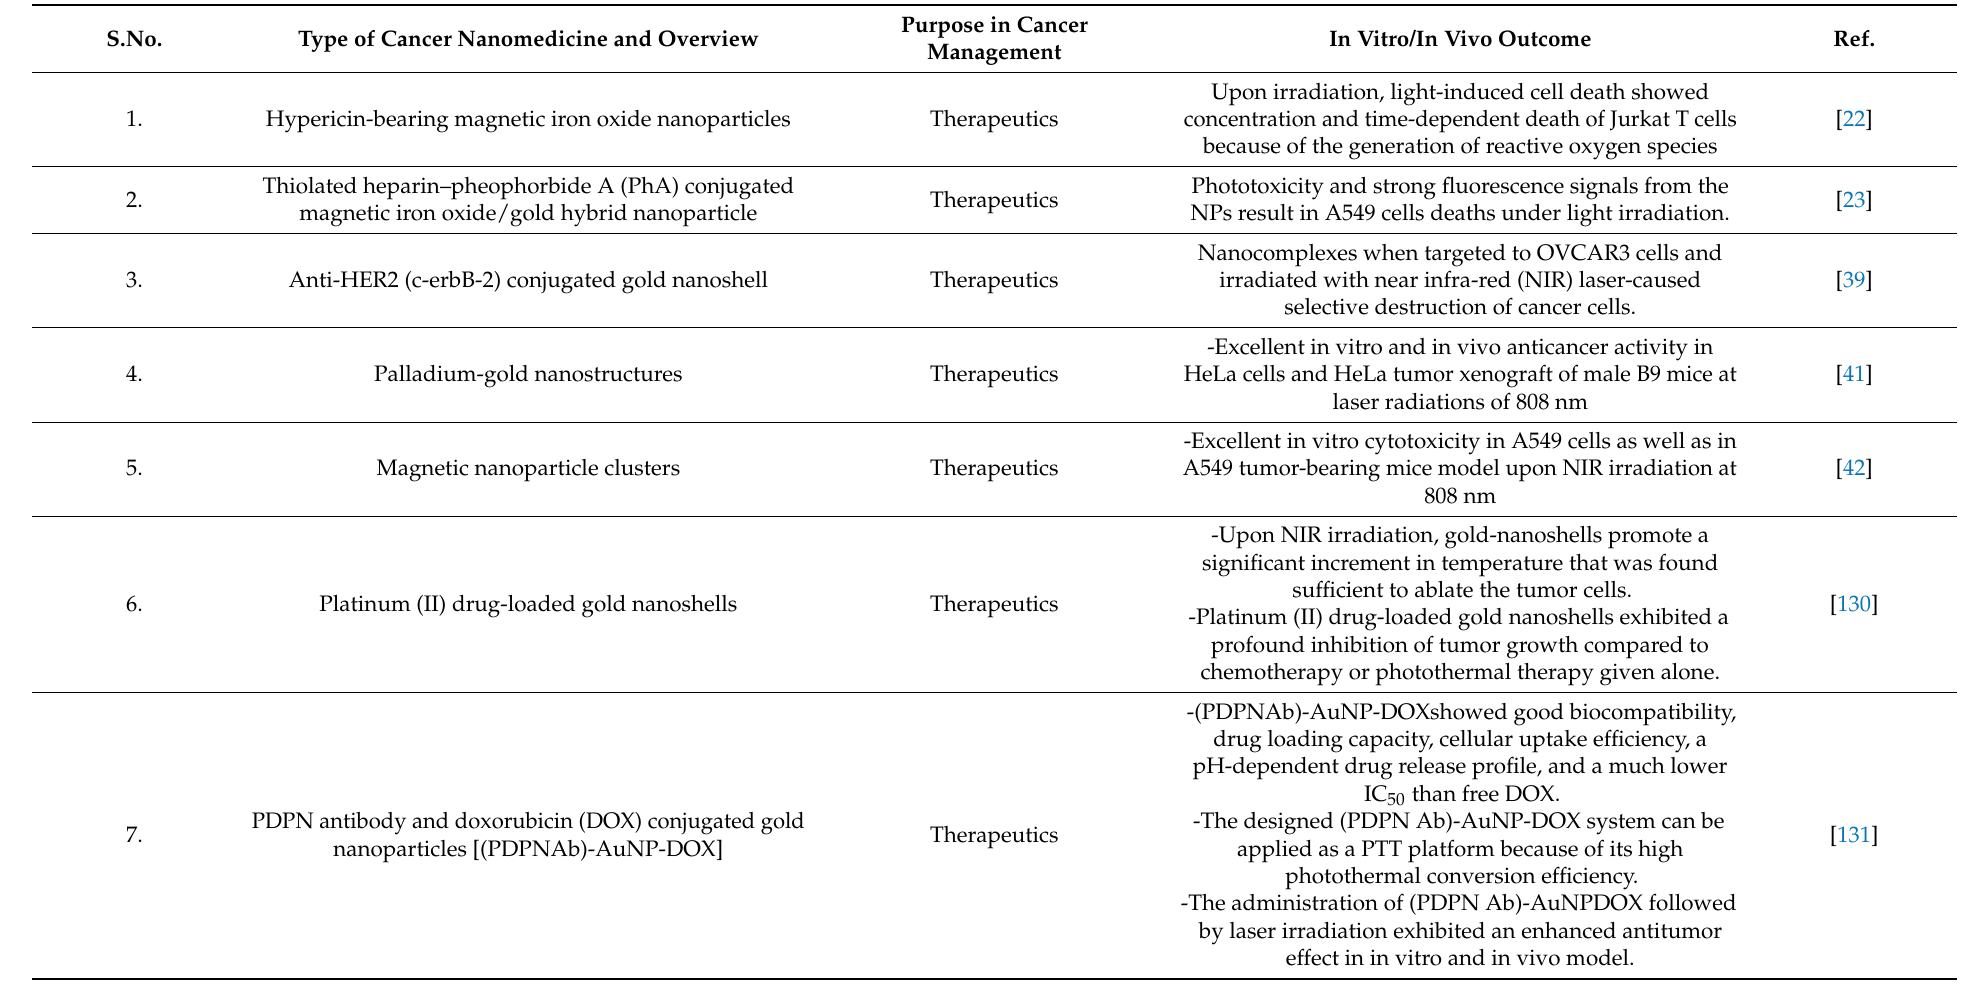
Table 2. Summary of recent nanomedicine products for therapeutic, diagnostic, and theranostic applications in cancer and their in vitro/in vivo outcome.